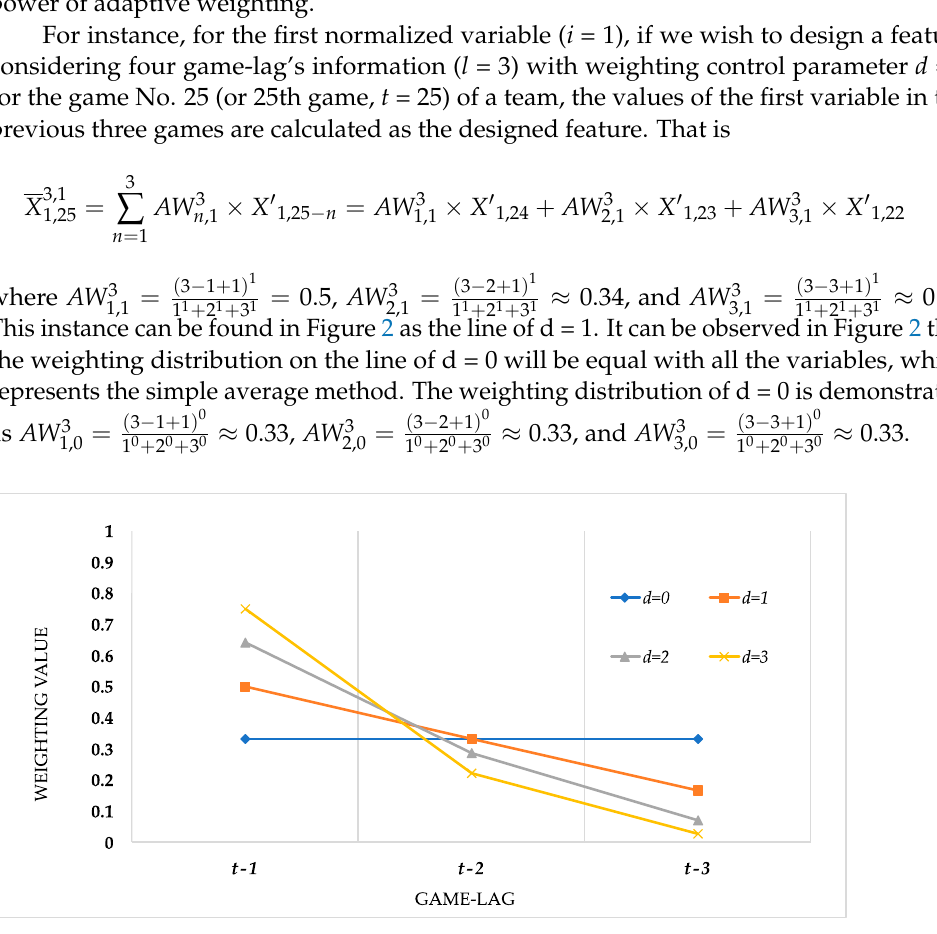
Figure 4. Weighting distribution of each data point with different weighting control parameter ( d ) from 0 to 3 under game-lag = 5.